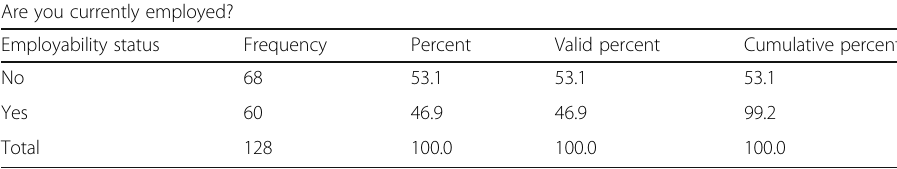
Are you currently